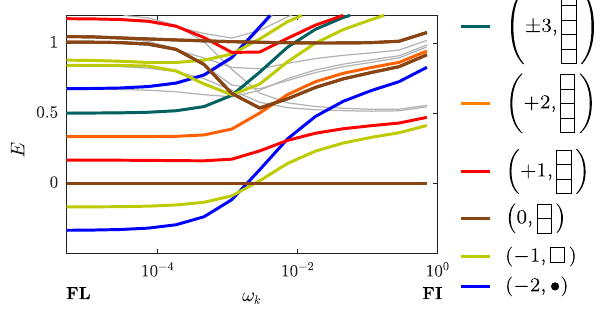
FIG. 6. NRG results for the SU(6) Kondo model with J U ¼ 0 . 1 , shown using as reference energy. The compu- tation was performed using QS pace [50] to exploit the model ’ s full U ð 1 Þ × SU ð 6 Þ symmetry. (NRG parameters: Λ ¼ 2 . 5 , N 2000 , D ¼ 1 .) keep ¼